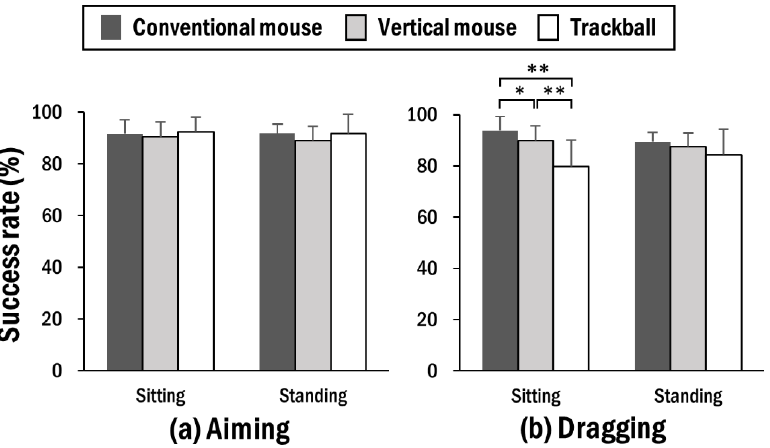
Figure 5. Average success rate during ( a ) aiming and ( b ) dragging tasks by working posture for pointing devices. Asterisks denote significant difference between pointing devices (* p < 0.05; ** p < 0.01).